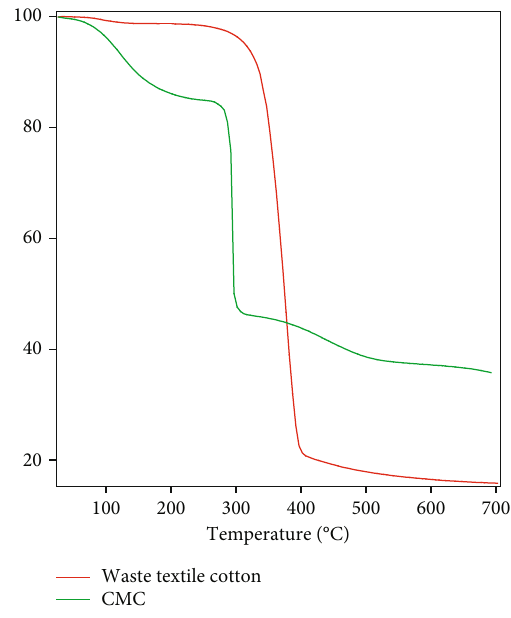
Figure 3: TG curves of waste textile cotton (Red) and CMC (DS — 0 : 998 ± 0 : 007 ,